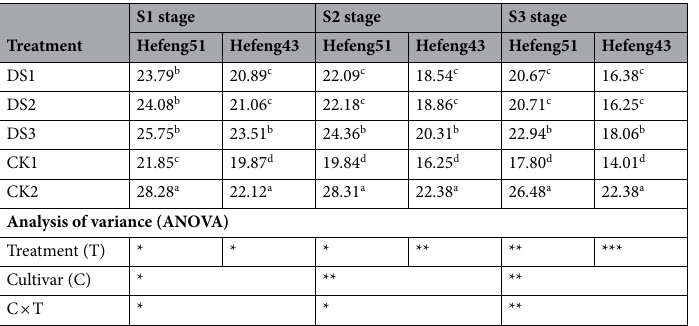
Table 9. Effects of foliar α-oxoglutarate and nitrogen on photosynthetic rate under drought stress (µmol CO 2 m −2 s −1 ). Means with same letter within columns are not significantly different ( P < 0.05) using LSD test. ***, **, *Significance at 0.001, 0.01, and 0.05, respectively.